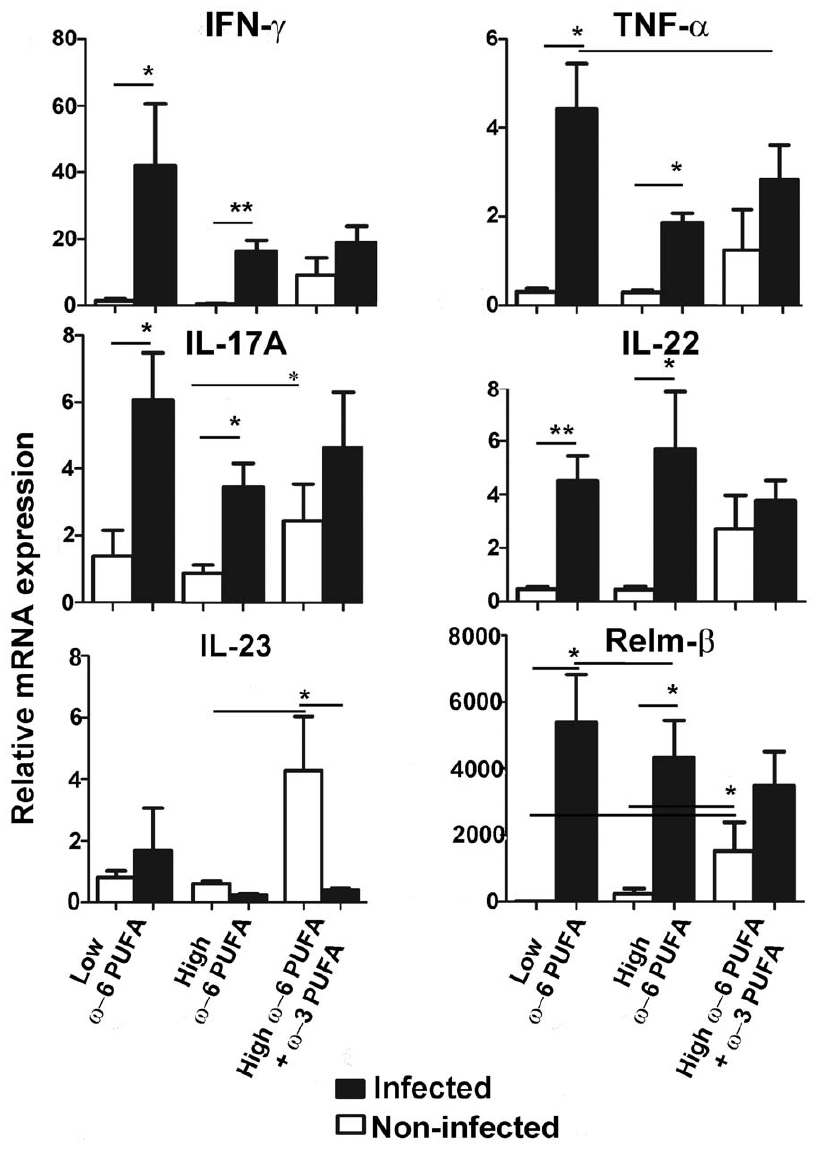
Figure 4. v -3 PUFA supplementation to v -6 PUFA rich diets impairs infection-induced cytokine and chemokine responses. qPCR analysis of colonic tissues revealed that both high and low v -6 PUFA diets were relatively similar where infection induced cytokine and the chemokine Relm- b responses. However, the v -3 PUFA supplemented diet had impaired IFN- c , TNF- a , IL-17A, IL-22 and IL-23, as well as the Relm- b responses evident by the lack of their induction during infection. (*, P , 0.05; **, P ,